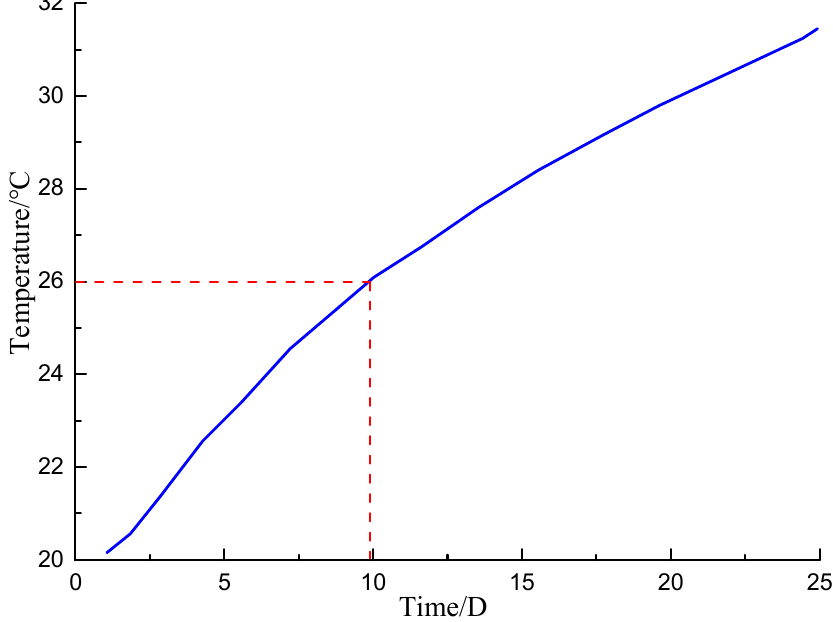
Figure 26. Temperature change curve of cable layout position.